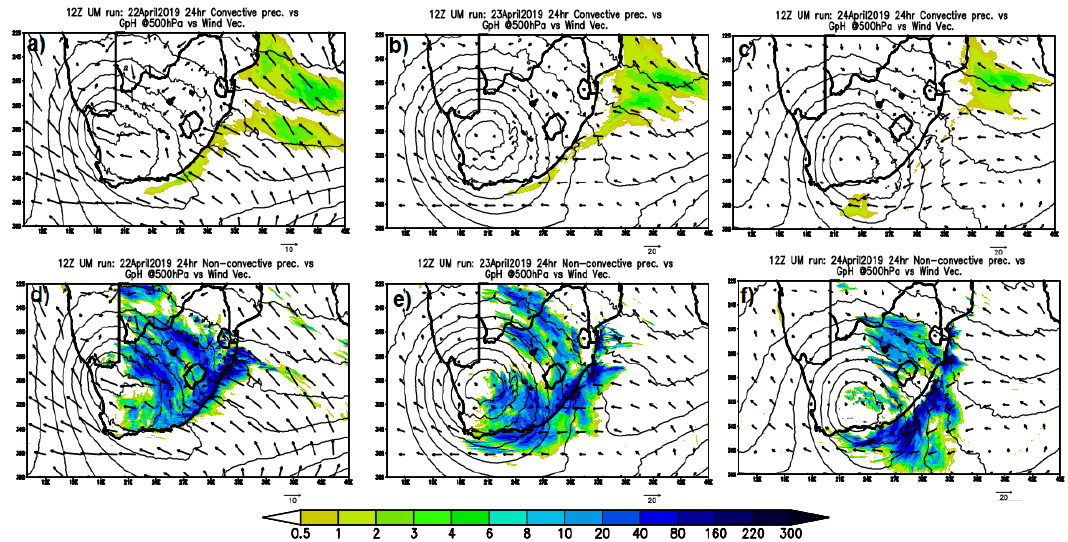
Figure 11. Geopotential heights at 500 hPa (thin contours) together with convection precipitation ( a – c ) at 12Z UM 24 h on the 22nd, 23rd and 24th April 2019. Bottom panels ( d – f ) are for the same time as in ( a – c ) but for non-convective precipitation. The vectors represent the wind vectors at 10 m above the ground.